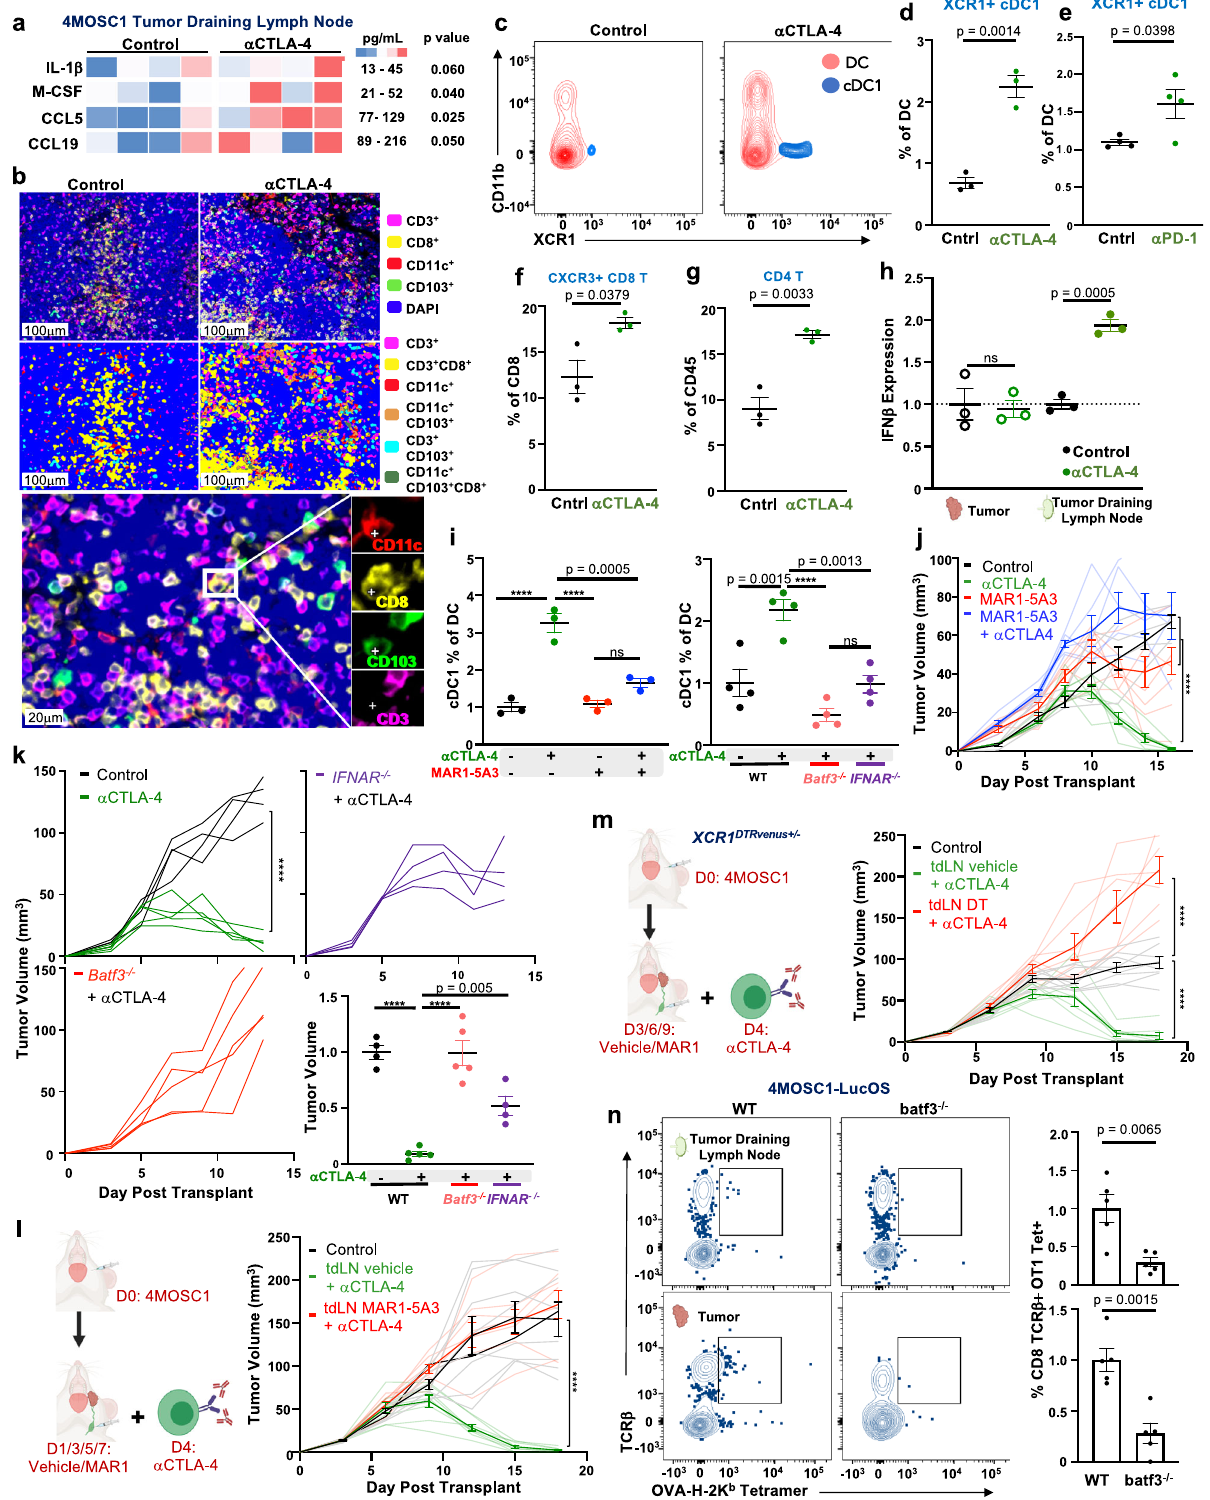
Rational IO treatment sequencing drives primary tumor treatment responses and immunosurveillance to protect against locoregional nodal metastasis . Given our observations that tdLNs are required for the response to ICI, we hypothesized that delivering ICI in advance of lymphatic ablation will achieve an optimal therapeutic response. To identify effective